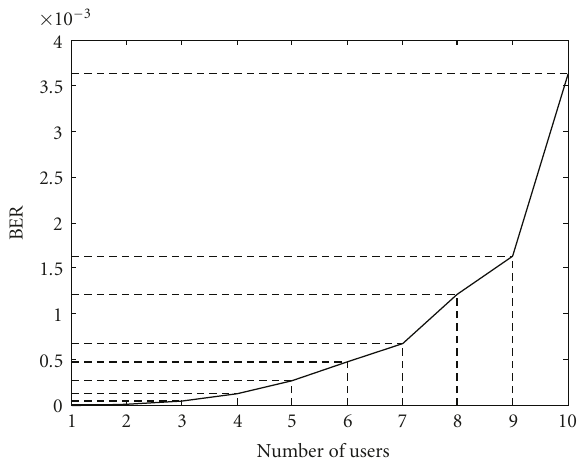
Figure 13: BER versus number of users at 12dB, 30Mbit/s, N s = 5.